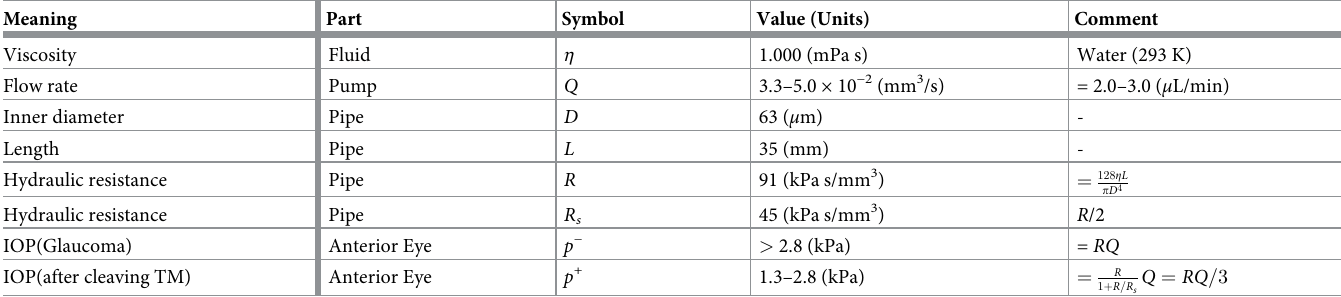
(2.0 MPa) [25]. In addition, its optical transparency facilitates a clear visualization of the SC through the cornea using a goniolens during the surgery simulation [11]. The anterior eye model was fabricated using the process as shown in Fig 5. First, the sclera and cornea parts were molded using PDMS as a material. By dividing the process into two steps, the only sclera part can be also made white-colored. The TM membrane was manufac- tured by spin-coating dextran as a water-soluble sacrificial layer [26] onto a curved-surface Table 1. Design